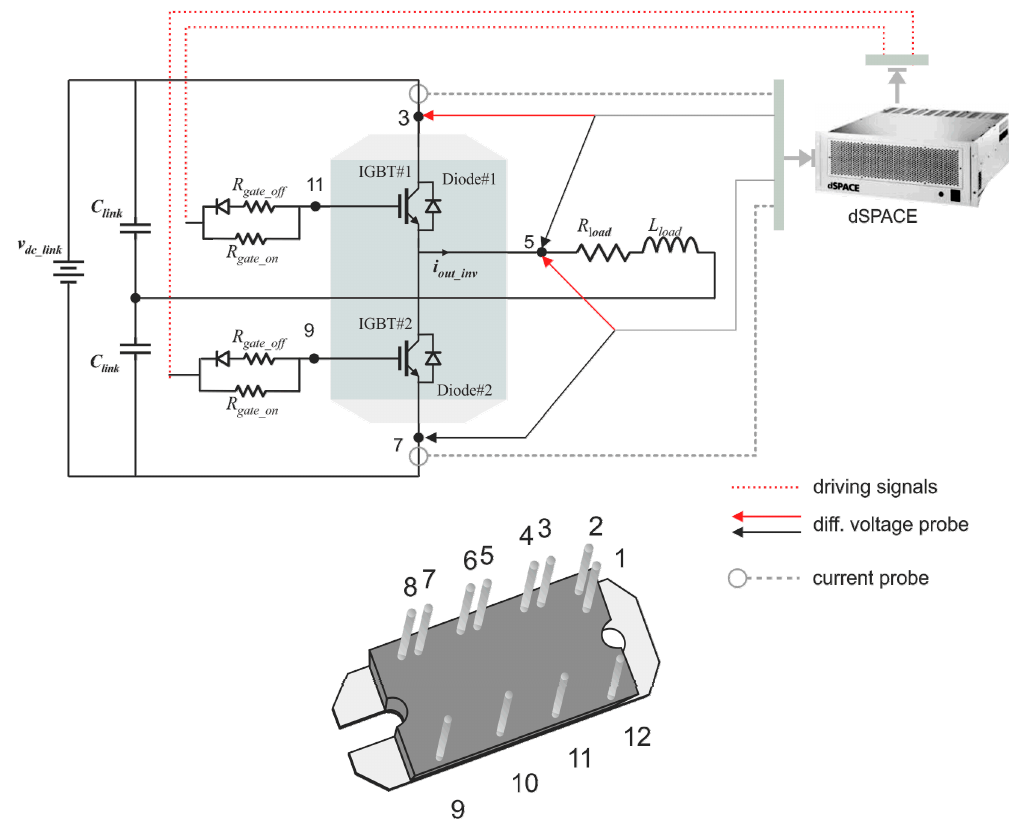
Figure 4. Schematic of the circuit employed for the experimental test.